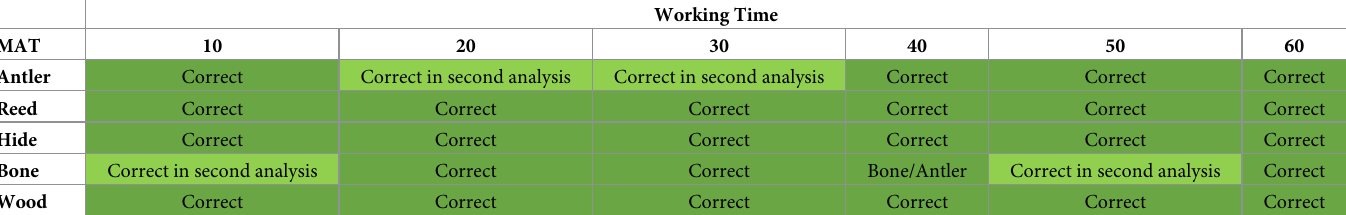
Table 8. Results of the blind classification of experimental tools per time of use when all the phases of use (from 10 to 60 minutes) are classified in the five worked materials and four intervals of use (0, 10–20 minutes, 30–40 minutes, 50–60 minutes). Working